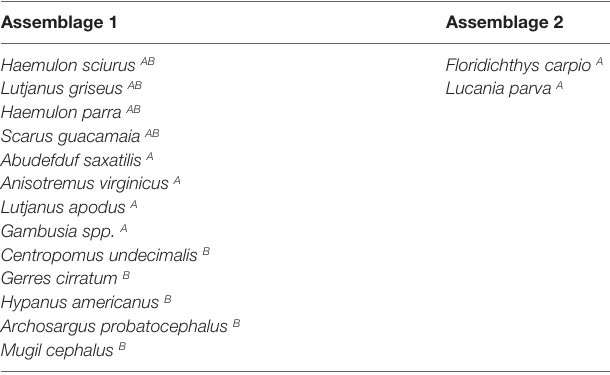
TABLE 3 | Fish species that distinguished Assemblages 1 and 2 from each other, based on the SIMPER results and abundances/biomass of fish